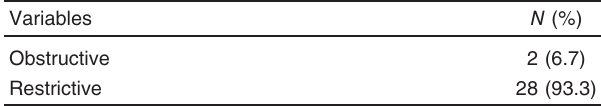
Table 2 Degree of airway limitation among study cases according to pulmonary function tests